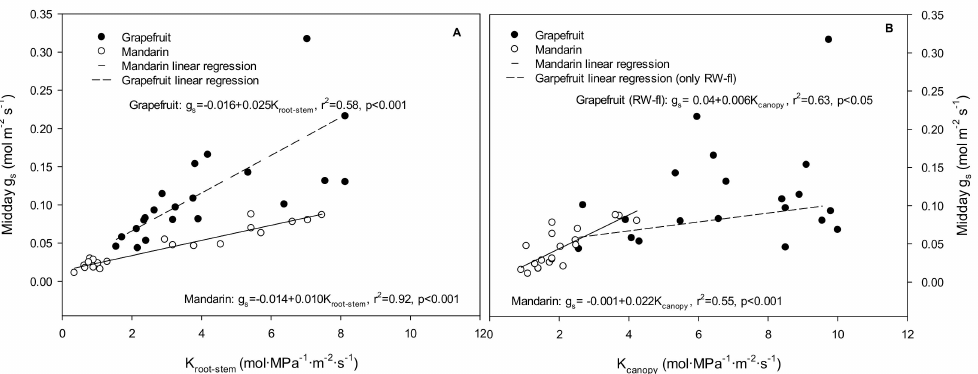
Figure 7. Correlations between midday stomatal conductance (midday g s ) and ( A ) root–stem hydraulic conductance (K root–stem ) and ( B ) canopy hydraulic conductance (K canopy ) for each treatment (TW-fI: transfer water—fully irrigated; TW-nI: transfer water—non-irrigated; RW-fI: reclaimed water—fully irrigated; RW-nI: reclaimed water—non-irrigated) and crop (grapefruit and